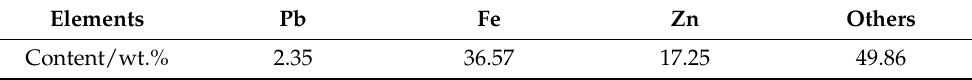
Table 6. The element content in acetic acid leaching residue.